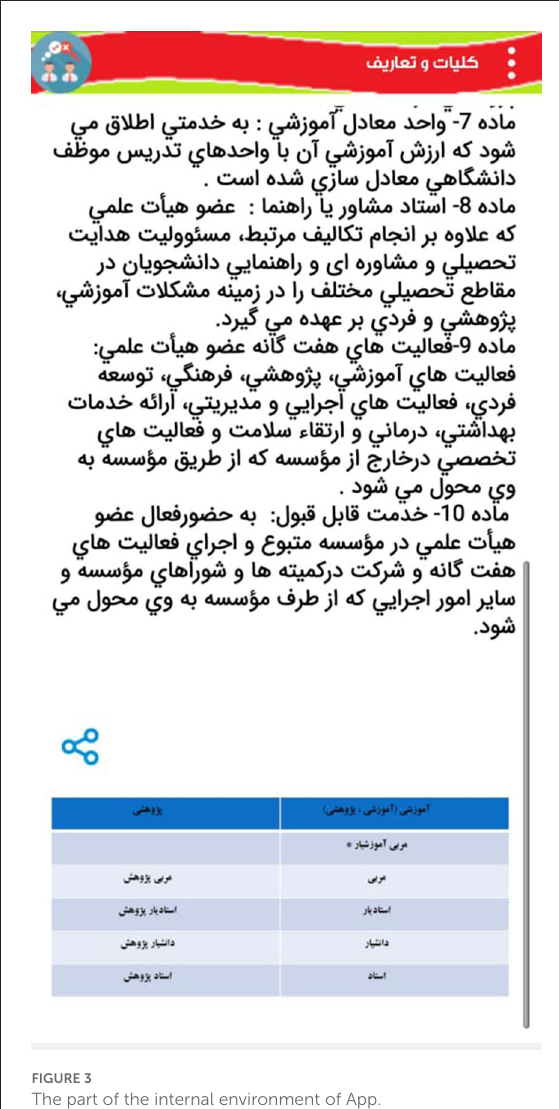
FIGURE3 The part of the internal environment of App.